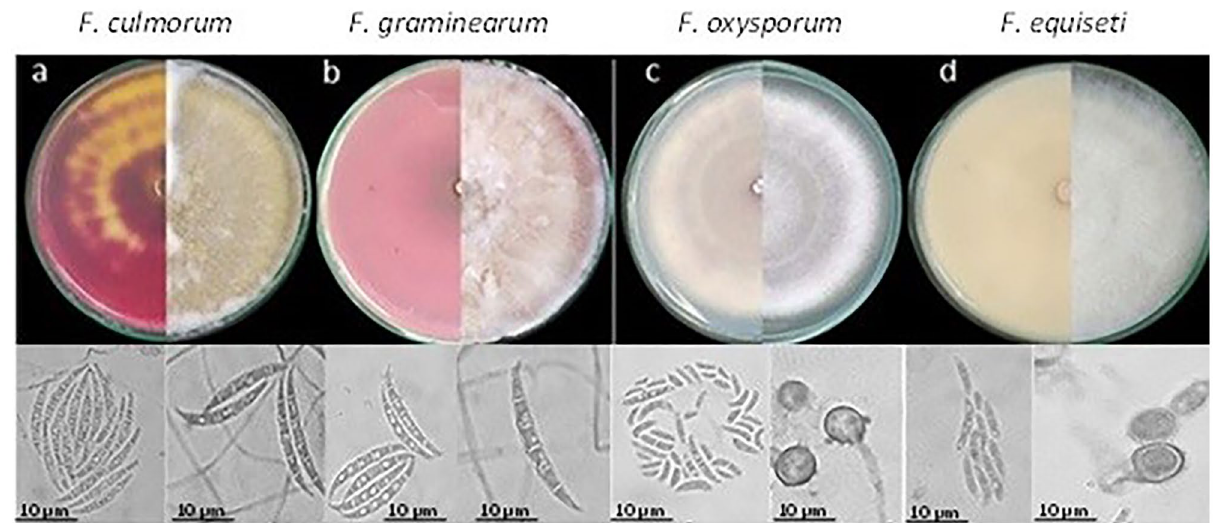
Figure 1. Macro and microscopic characteristics of the Fusarium complex associated with quinoa crops. On top the growth of the colonies of the 4 species F. culmorum , F. graminearum F. oxysporum and F. equiseti in PDA culture media after 7 days of incubation at 28 °C, at back side (right) and front side (left). Down the microscopic structures obtained after 14 days of incubation in SNA at 25 °C, and 12-h light/dark photoperiod. Scale of 40 ×